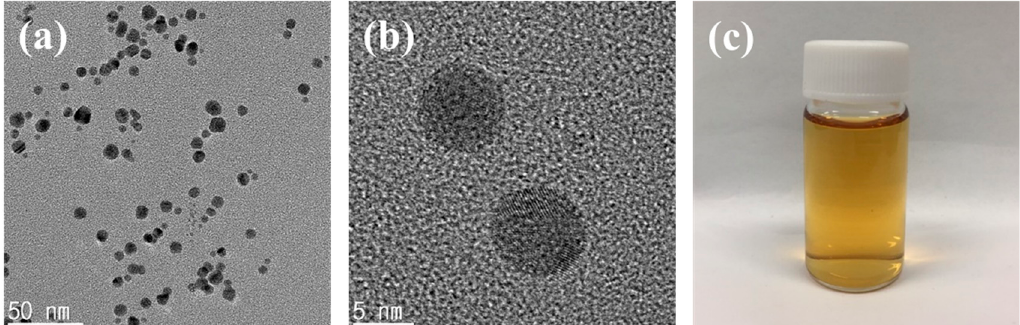
Figure 1. TEM image ( a ) and HR-TEM image ( b ) of Ag nanospheres and ( c ) digital photograph of the resultant solution of Ag nanospheres.